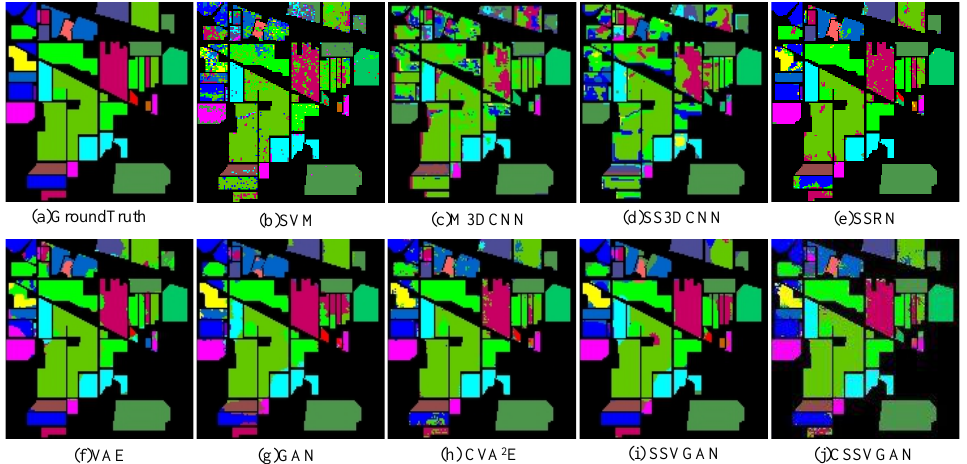
Figure 10. Classification maps for the IP dataset with 5% labeled training samples: ( a ) GroungTruth ( b ) SVM ( c ) M3DCNN ( d ) SS3DCNN ( e ) SSRN ( f ) VAE ( g ) GAN ( h ) CVA 2 E ( i ) SSVGAN ( j ) CSSVGAN.